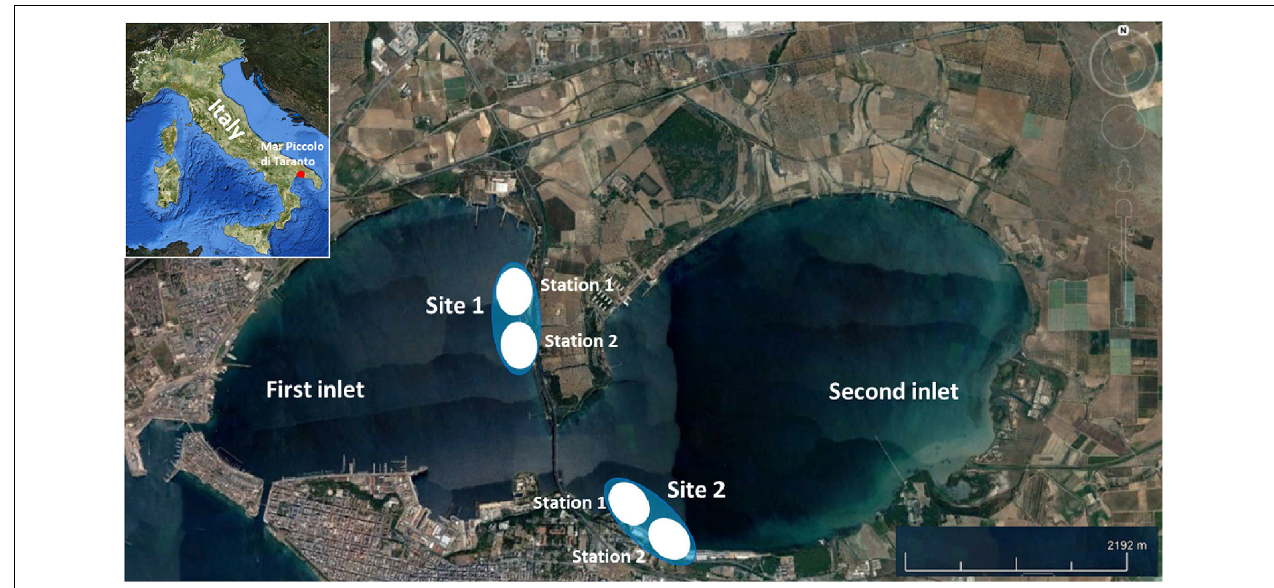
FIGURE 1 | Study area. Site 1, The sampling area only occasionally patrolled by supervisory bodies. Site 2, The coastline is strictly patrolled because of the presence of military structures.